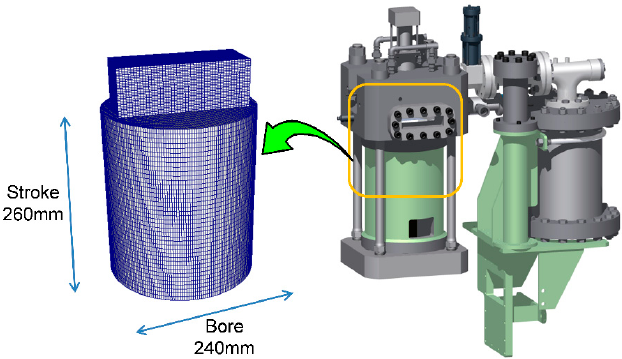
Figure 10. The computational domain of RCEM applied in KIVA-3V.